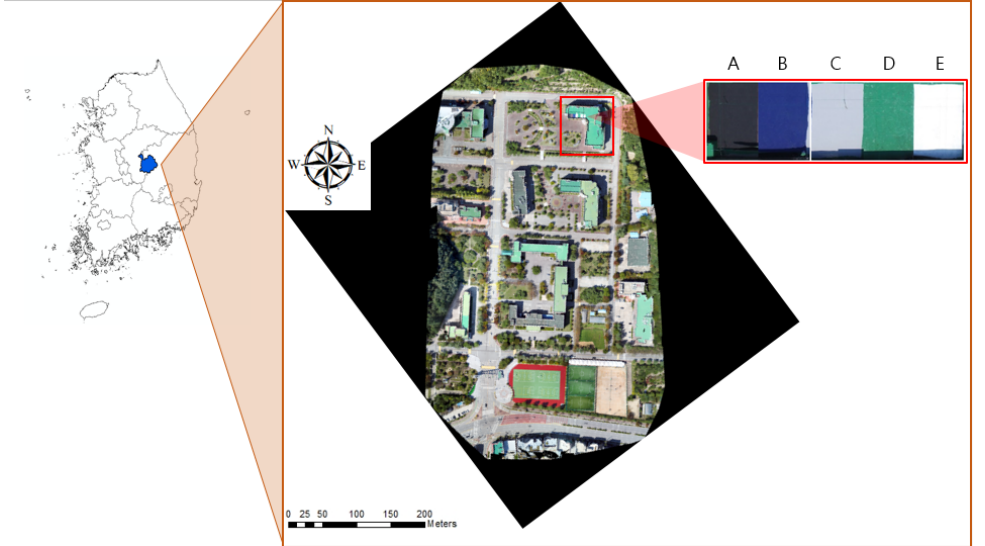
Figure 2. Study area. The red border represents the color for the warm roof performance evaluation. The five colors are presented as capital letters: A: black, B: blue, C: gray, D: green, and E: white.